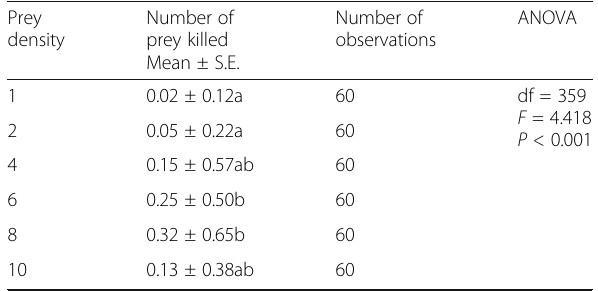
Table 2 Mean number of P. truncatus pupae killed in 24 h by the predator A. biannulipes in function of